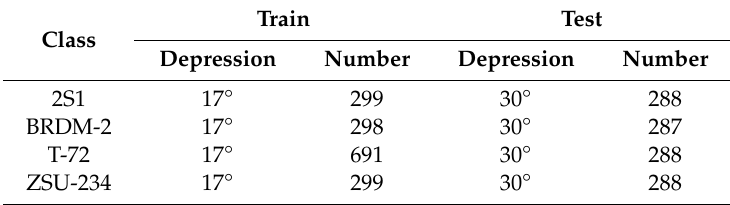
Table 2. Number of training and test samples for extended operating conditions (EOC)-1 (large depression variation).